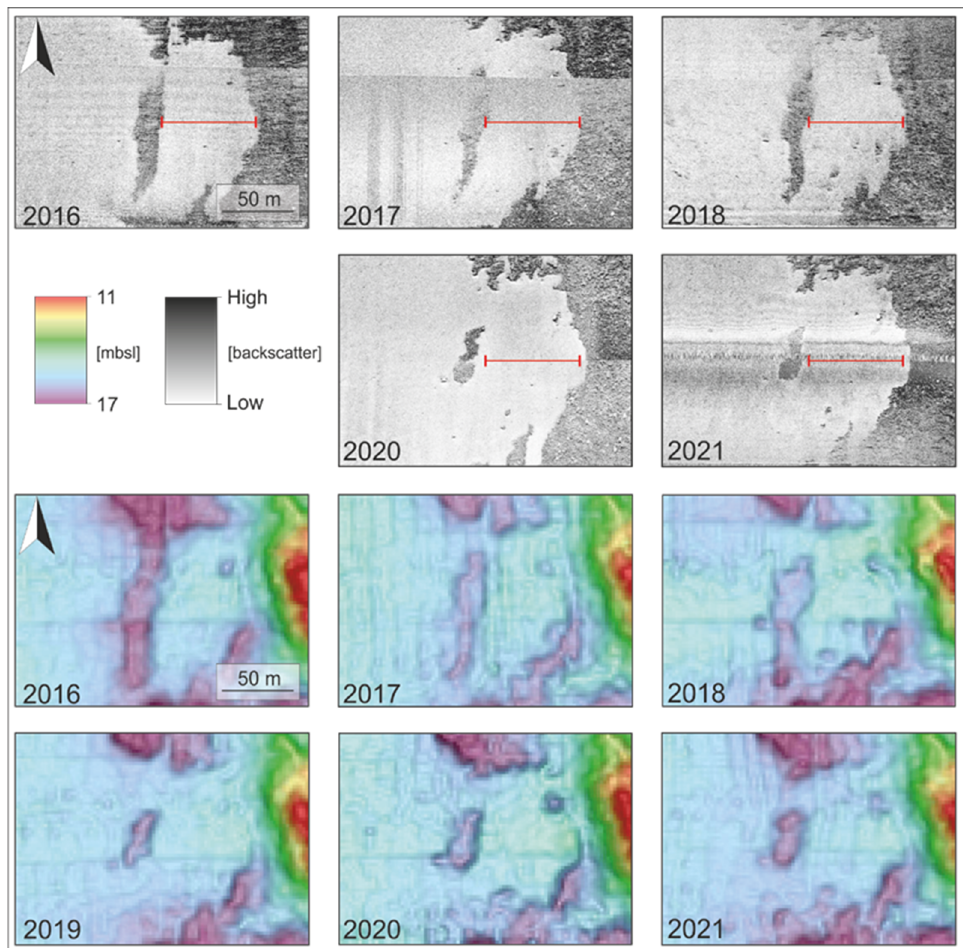
Figure 4. Closeup of side-scan backscatter ( top ) and multibeam bathymetry ( bottom ) on the west side of the working area show how previously exposed reef becomes increasingly covered with sand.